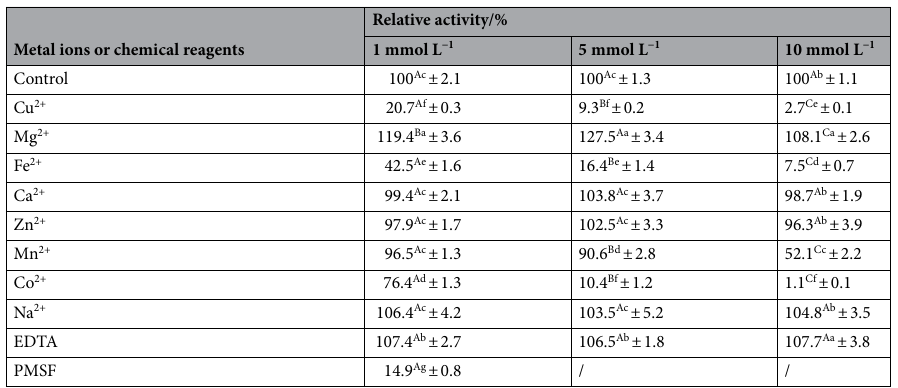
Table 2. Effect of metal ions or chemicals on the enzymatic activity of CapA. Values are mean ± standard deviation. Analysis performed in triplicate. Different lowercase superscripts in the same column indicate statistically significant difference (p < 0.05) caused by different metal ions or chemicals within the same concentration. Capital letters in the same row indicate statistically significant difference (p < 0.05) caused by different concentration within the same metal ions or chemicals. “/” means no detectable enzyme activity.